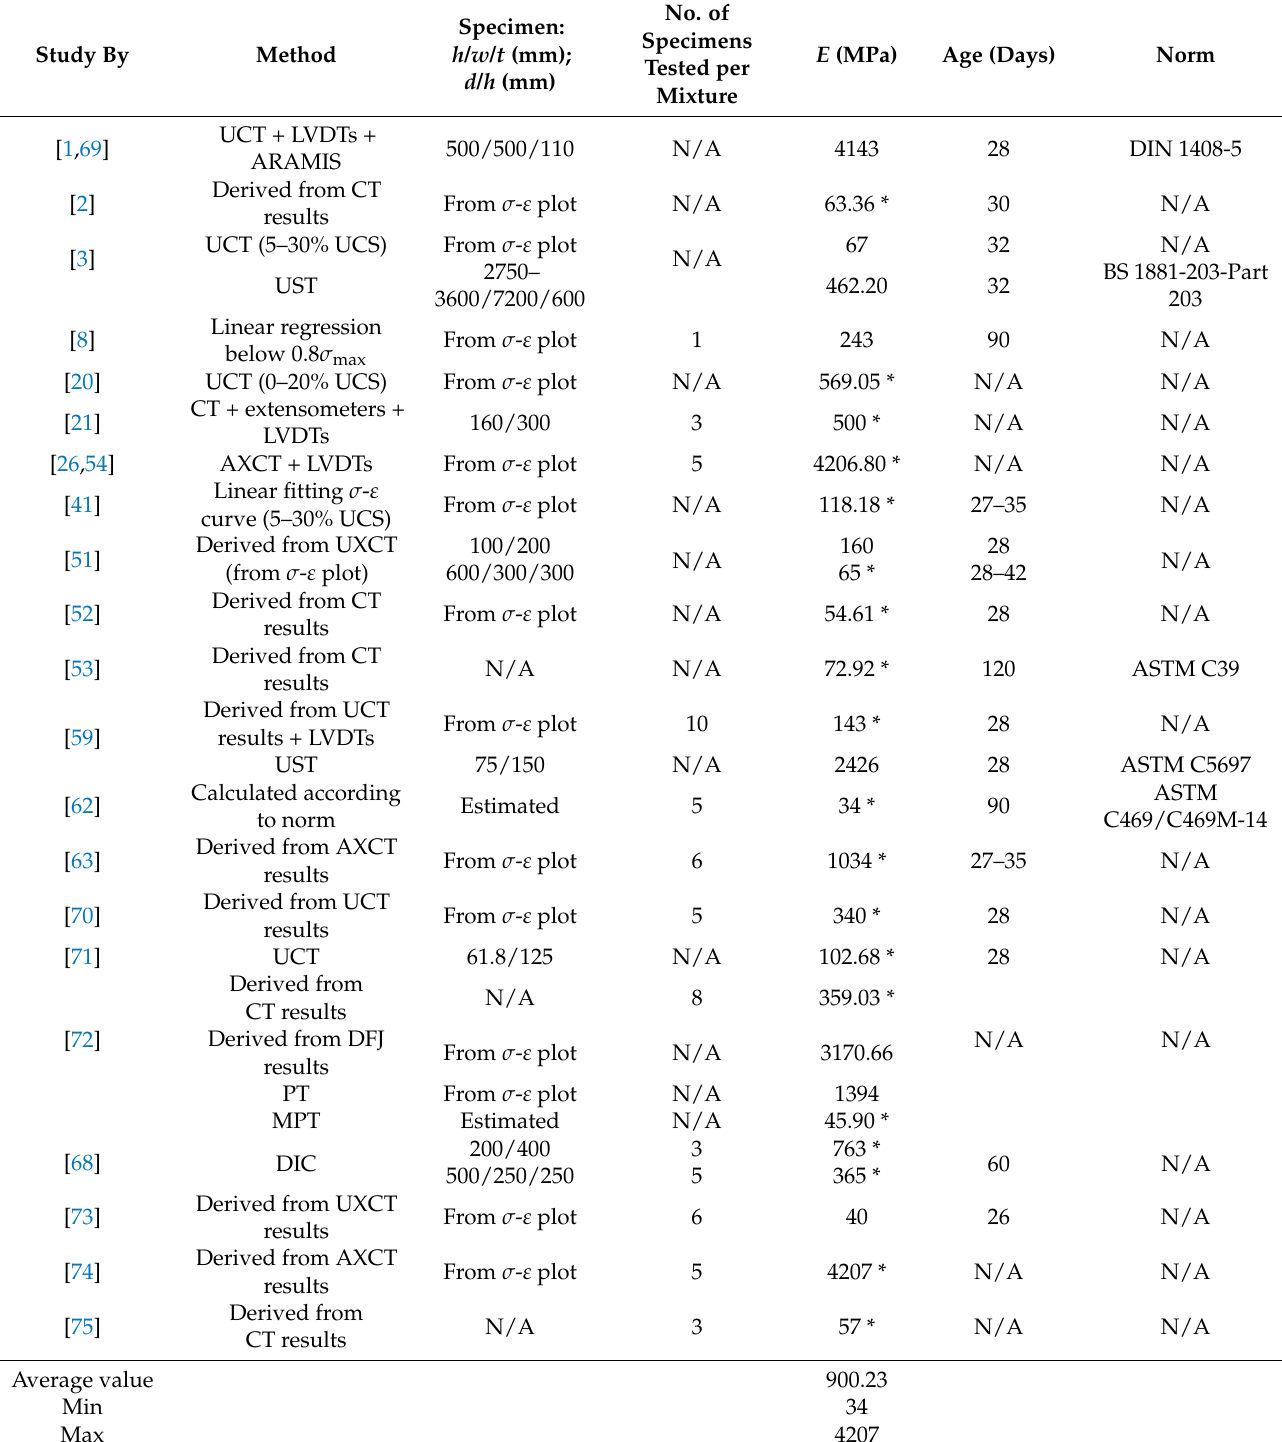
Table 4. Modulus of elasticity ( E ) values obtained at different age, along with description of methods, specimens, and norms